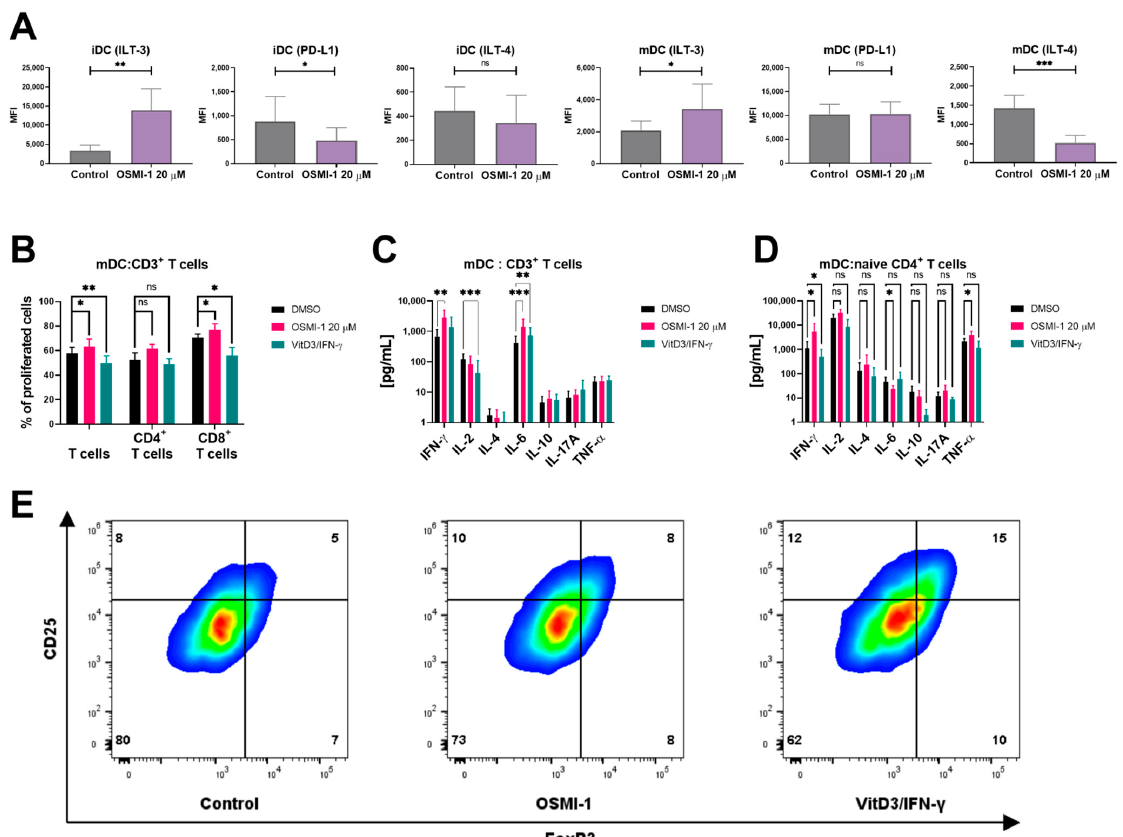
Figure 5. Characterisation of OSMI-1 treated mature moDCs impacts on allogeneic T lymphocytes. ( A ) Characterisation of moDC surface markers after exposure to OSMI-1. Shown are mean MFI values ± SD from 8–11 independent experiments. ( B ) Representative T-cell proliferation after 6 days of co-culture of T cells (CD3 + ) and mature moDCs. T cells were cultured with either untreated or OSMI-1 or VitD 3 /IFN- γ treated mature moDCs. ( C ) Cytokine concentrations in supernatants taken from co-cultures of CD3 + cells:moDCs after 6 days. Supernatants were analysed for the presence of IL-2, IL-4, IL-6, IL-10, IL-17A, IFN- γ and TNF- α . The results are expressed as means ± SD of four independent experiments. ( D ) The T cell-polarizing capacity of mature moDCs was determined by co-culturing differently treated mature moDCs with naïve allogeneic CD4 + CD45RA + T cells. After 14 days, the supernatants were sampled and analysed for the presence of IL-2, IL-4, IL-6, IL-10, IL-17A, IFN- γ and TNF- α . The results are expressed as means ± SD of two to three independent experiments. ( E ) The T cell-polarizing capacity of mature moDCs toward regulatory T cells (Tregs) was determined by co-culturing differently treated mature moDCs with naïve allogeneic CD4 + CD45RA + T cells. After 14 days, the cells were washed and analysed by flow cytometry for the expression of CD25 and FoxP3. Representative results of CD25 and FoxP3 expression are presented as dot plots. Statistical significance between individual pairs was calculated using Student’s t -test; p -value < 0.05 was considered statistically significant (* p < 0.05; ** p < 0.01; *** p < 0.001; ns, nonsignificant). iDCs, immature moDCs; mDCs, mature